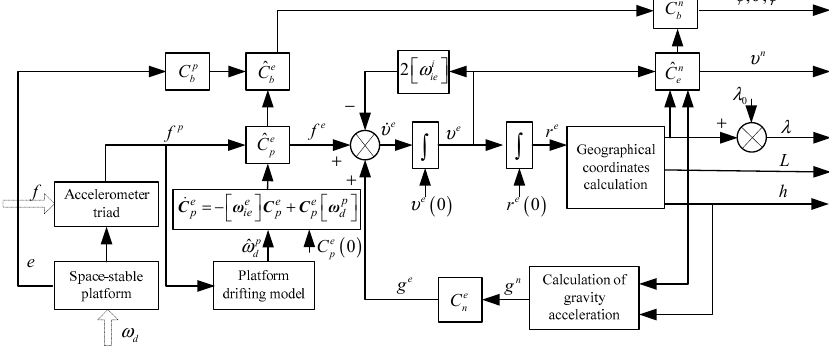
Figure 2. Mechanization of space-stable platform Inertial Navigation System (INS).